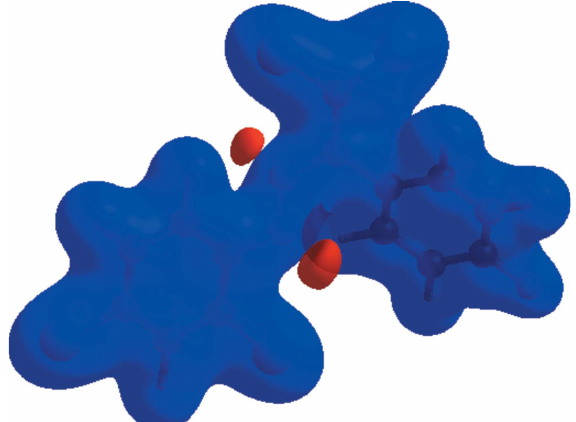
Figure 6 View of the three-dimensional Hirshfeld surface of the title compound plotted over electrostatic potential energy in the range (cid:4) 0.0500 to 0.0500 a.u. using the STO-3 G basis set at the Hartree–Fock level of theory. Hydrogen-bond donors and acceptors are shown as blue and red regions around the atoms, corresponding to positive and negative potentials,